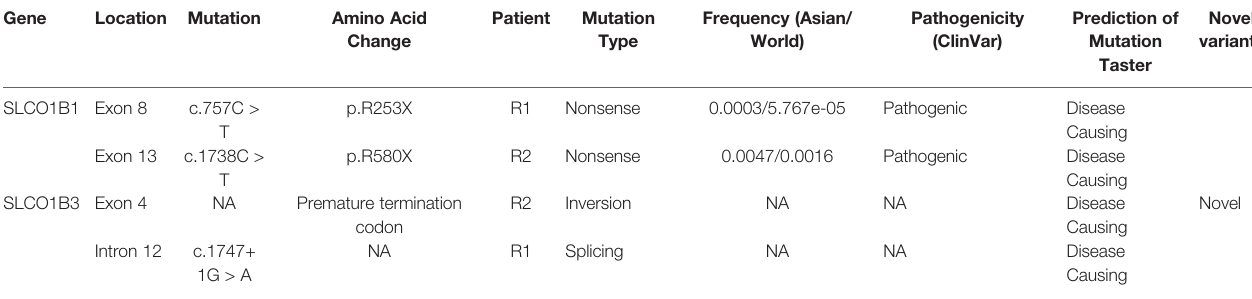
TABLE 1 | Pathogenic SLCO1B1 and SLCO1B3 variants identi fi ed in patients with Rotor syndrome. Gene Location Mutation Amino Acid